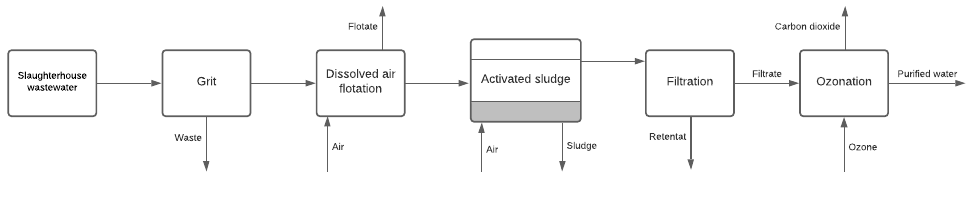
Figure 9. Flow Sheet